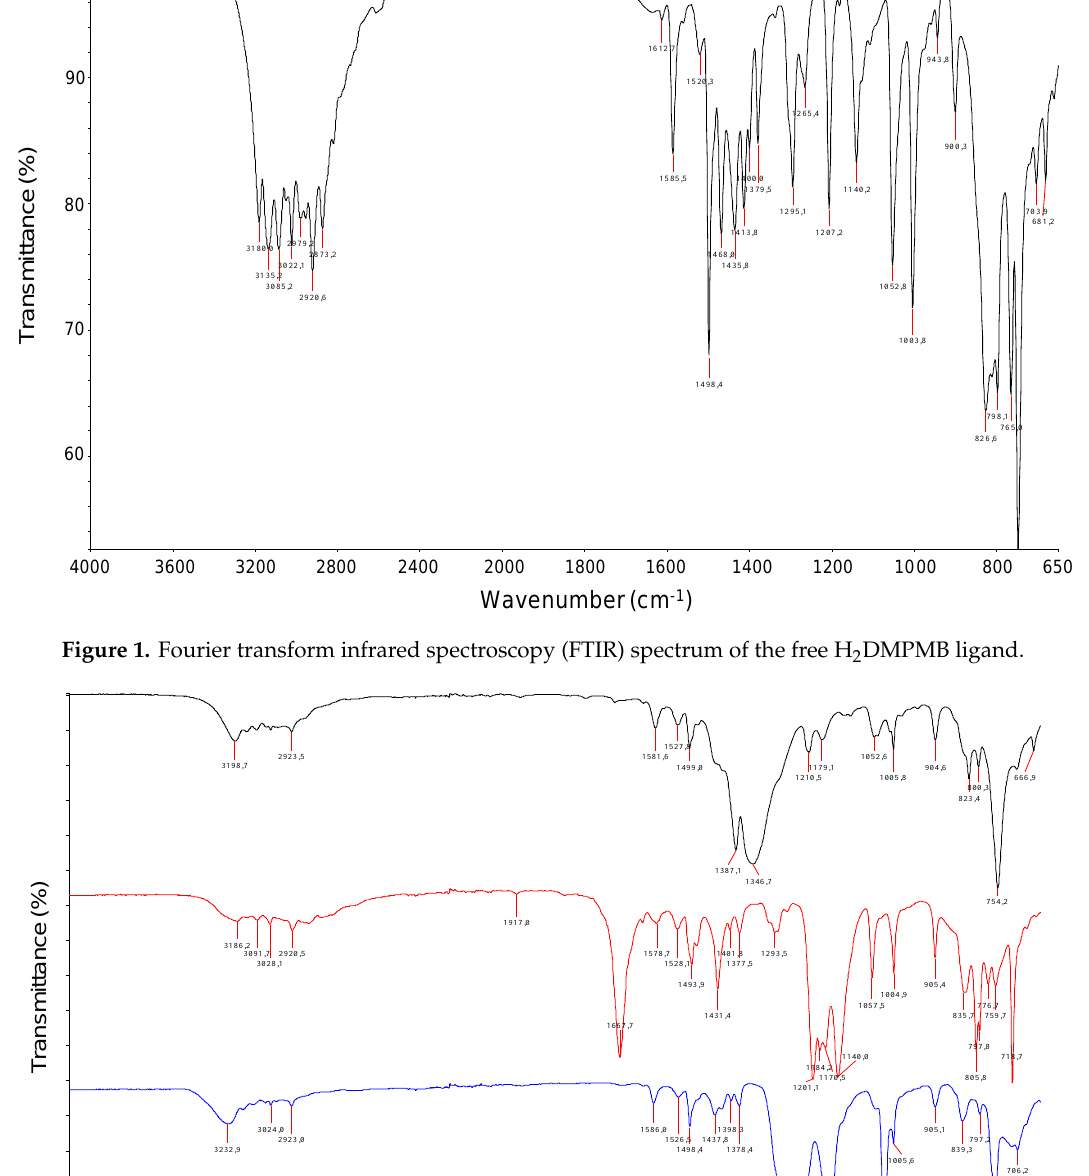
Figure 1 . Fourier transform infrared spectroscopy (FTIR) spectrum of the free H 2 DMPMB ligand .